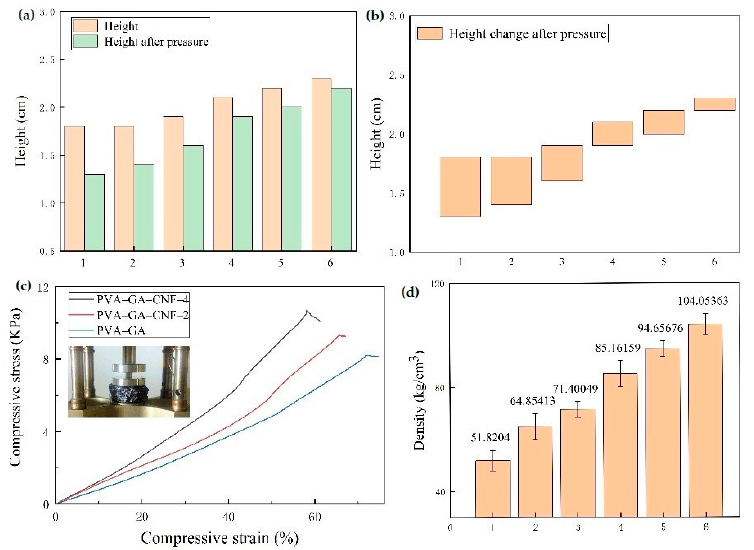
Figure 6. ( a ) Height diagram, ( b ) height change diagram after pressure, ( c ) stress–strain curve and ( d ) density numerical diagram of PVA–GA aerogel and PVA–GA–CNF ‐ (1–5) aerogel. Table 1. Maximum pressure of CNF composite aerogel, GA composite aerogel and PVA composite aerogel. Composite Aerogels Maximum Allowable Pressure (kPa)